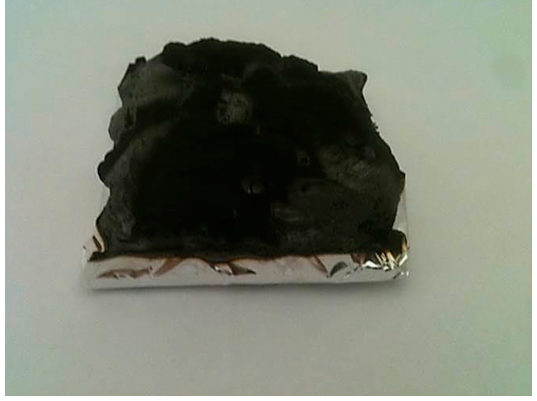
Figure 8. Residue of H/E-15APP after cone calorimetry tests.